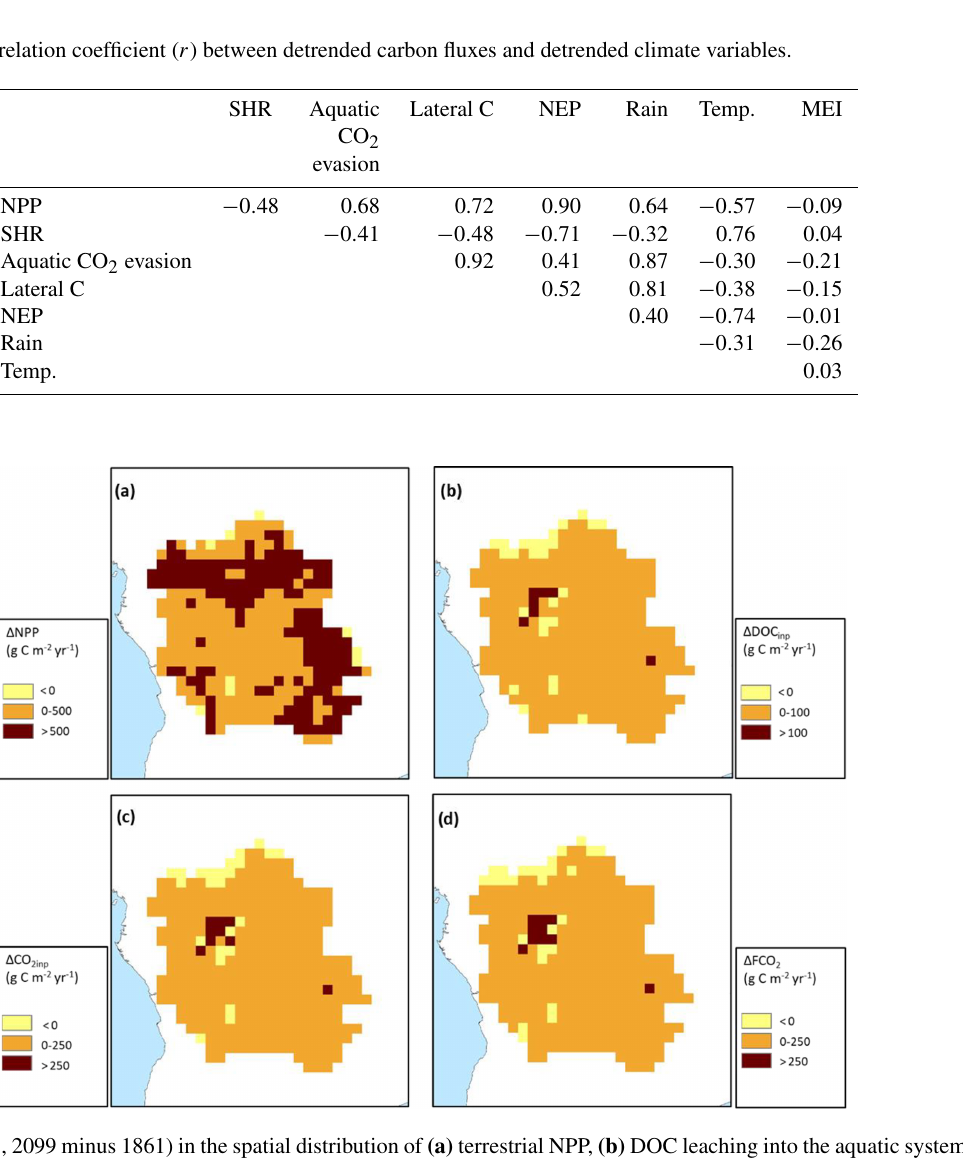
Figure A1. Change ( (cid:49) , 2099 minus 1861) in the spatial distribution of (a) terrestrial NPP, (b) DOC leaching into the aquatic system, (c) CO 2 leaching into the aquatic system, and (d) aquatic CO 2 evasion. All are at a resolution of 1 ◦